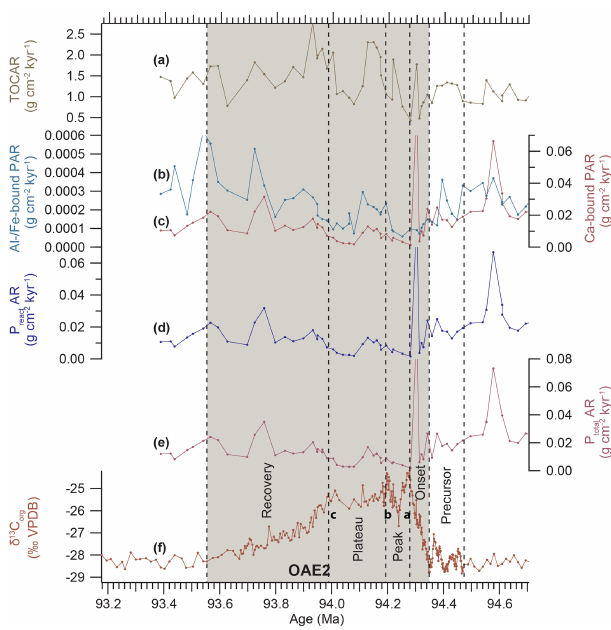
Figure 8. Phosphorus accumulation rates across OAE2 in Tar- faya Basin Core SN ◦ 4 (age model based on Meyers et al. 2012a). (a) Accumulation rate of organic carbon (TOCAR). (b) Accumula- tion rate of aluminium- and iron-bound phosphorus (Al / Fe-bound PAR). (c) Accumulation rate of calcium-bound phosphorus (Ca- bound PAR). (d) Accumulation rate of reactive phosphorus calcu- lated as the sum of Al/Fe- and Ca-bound P (P react AR). (e) Ac- cumulation rate of total phosphorus (P total AR). (f) δ 13 C org . Sta- ble isotope data and organic carbon concentrations from Kuhnt et al. (2017) and Beil et al. (2018); a–c indicate prominent maxima following Voigt et al.